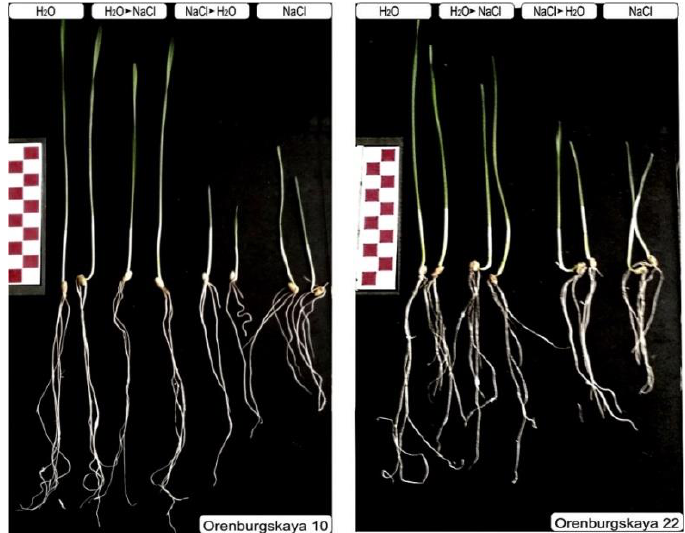
Figure 2. Ten-day-old seedlings of soft and durum wheat after germination under normal conditions and chloride salinization, according to the scheme. Scale ruler with 1 cm divisions.